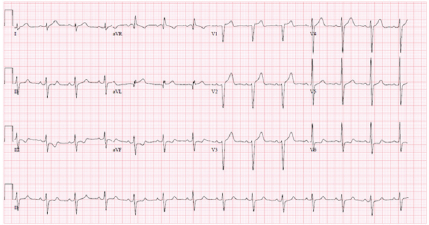
Figure 1: 12-lead EKG showing ST elevation changes at V1–V3.